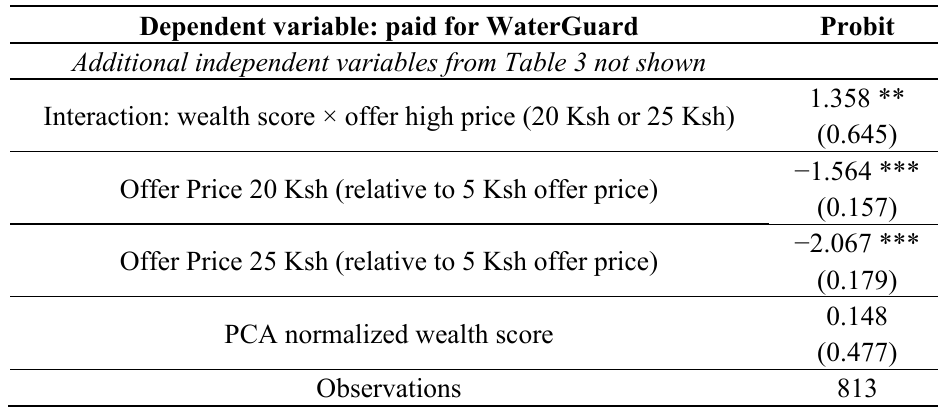
Table 4. Wealth score and high offer price interaction term and component variables from probit regression model for the purchase of